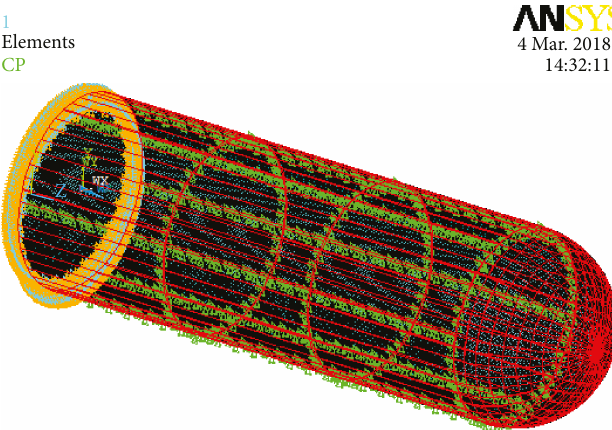
Figure 10: FEM analysis model of the habitat modules.